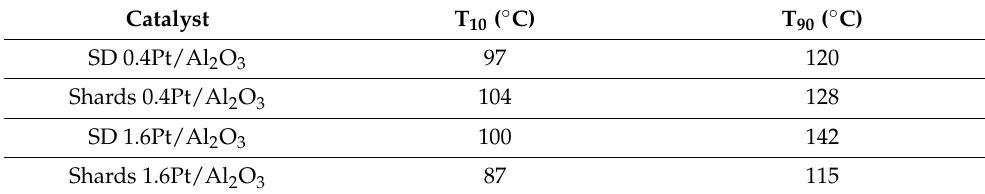
Figure 8. Light-off curves of conversion of toluene to CO 2 as a function of reaction temperature for RCT samples of SD microparticles and Shards with different Pt loadings: ( a ) 0.4 wt% Pt, and ( b ) 1.6 wt.% Pt. Reaction conditions: catalyst mass 100 mg, 10 ppm toluene in dry air, flow rate of 0.5 L/min, and gas hourly space velocity (GHSV) ~ 5000 h −1 . Table 2. Comparison of temperatures required for 10% (T 10 ) and 90% (T 90 ) conversions of toluene for theSD microparticles and Shards with different Pt loadings.